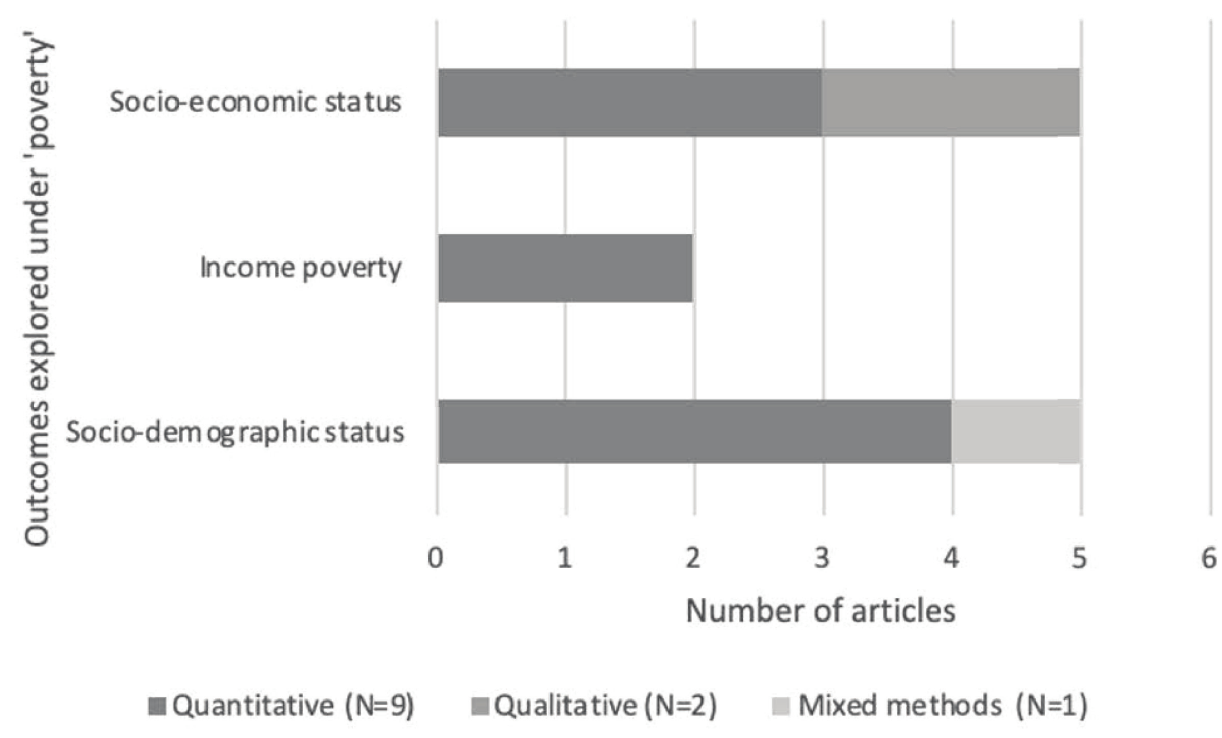
Fig 5. Outcomes explored related to poverty in papers included our